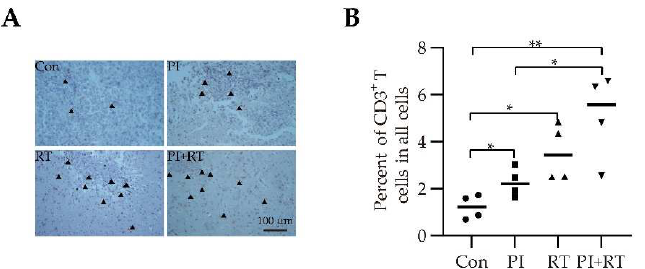
Figure 5. The effect of PI in combination with RT on the infiltration of CD3 + T cells in tumor tissues in orthotopic GL261-Luc glioma-bearing mice. ( A ) Immunohistochemical staining and quantification of CD3 at 400 × magnification. Black arrows showed CD3-expressing T cells. ( B ) The percentage of CD3 + T cells among all calculated cells in tumor tissues ( n = 4). The statistical differences between groups were analyzed with an unpaired two-tailed Student’s t -test. The data showed the mean ± SEM. Statistical differences were indicated by the p values, *, p ≤ 0.05; **, p ≤ 0.01.